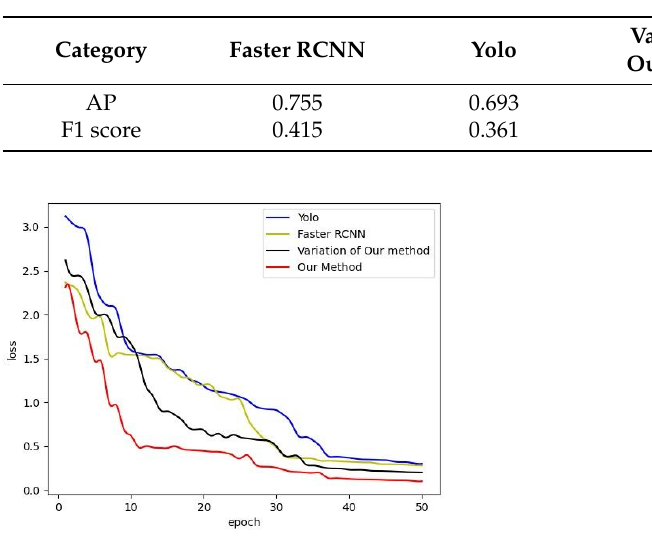
Figure 5. Loss curves of the four experiments.